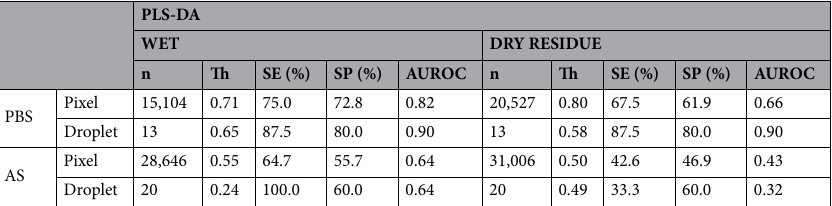
Table 1. Classification performance of the PLS-DA method. Here, n is the sample size, Th is the value of the classification threshold, SE denotes the sensitivity, SP is the specificity, and AUROC is the area under the receiver operating characteristic